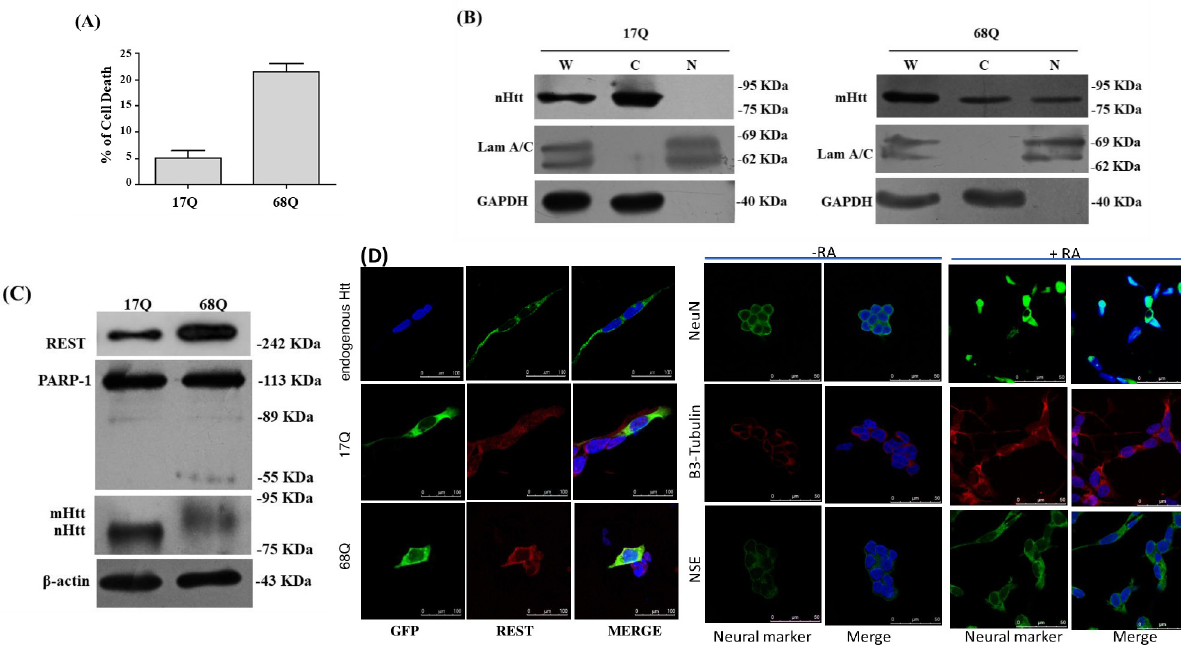
Fig 2. Transfected mHtt increases the level of REST and induces apoptosis in differentiated SH-SY5Y cells. (A) Cell death of differentiated SH-SY5Y cells transiently transfected with expression vectors GFP-480-17Q or GFP-480-68Q was determined by the MTT method 24 h after transfection. The 0% values of viable cells were defined by the measurement of cells transfected with expression vector for GFP. At 24 h, mHtt resulted in more death compared with wild-type Htt. Data are representative of three independent experiments ( P < 0.005). (B) Analysis of the subcellular localization of mHtt. Differentiated SH-SY5Y cells transiently transfected at 15 h were fractionated into cytoplasmic (C) and nuclear (N) fractions and were analyzed by Western blot for expression of normal and mutant Htt, respectively. Whole cell extract (W) served as a control. GAPDH and Lamin A/C served as a loading control for cytoplasmic and nuclear proteins, respectively. (C) PARP proteolysis was measured in lysates from cells transfected with expression vectors. Immunoblotting showed that mHtt is toxic and induces more cleavage PARP-1 products than normal Htt. Also, mHtt increased REST expression by around double. β -actin was used to assess the quality of total protein loading. P < 0.005. (D) Confocal microscopy of cells transfected with expression vectors at 24 h. GFP fluorescence (green), REST is in red and DNA stained with 4’ 6-diamido-2-phenylindole (DAPI) (blue). Cells tranfected with expression vector GFP-480-68Q showed signs of neurodegeneration and early apoptosis events such as morphological changes, membrane blebbing, cell shrinkage, shorter neurites, and sometimes fragmented nuclei, especially condensed and/or fragmented nuclei compared with normal Htt. As controls for neuronal differentiation, we include three neuronal markers; NeuN, β 3-Tubulin and NSE (Neuron- Specific